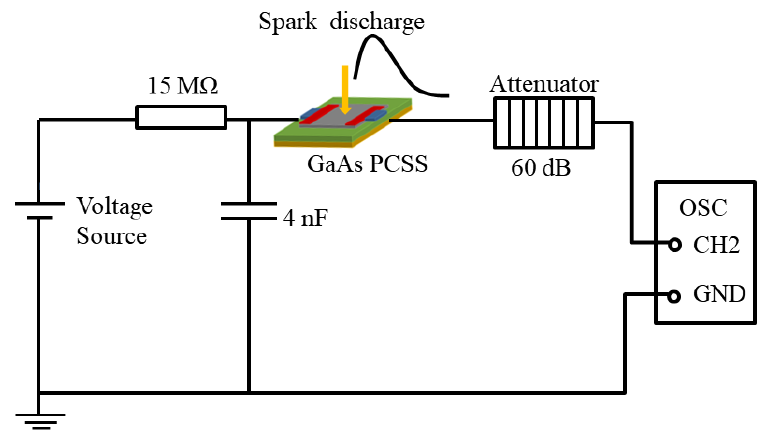
Figure 7. Test circuit for a lateral GaAs PCSS charged by a 4 nF capacitor.